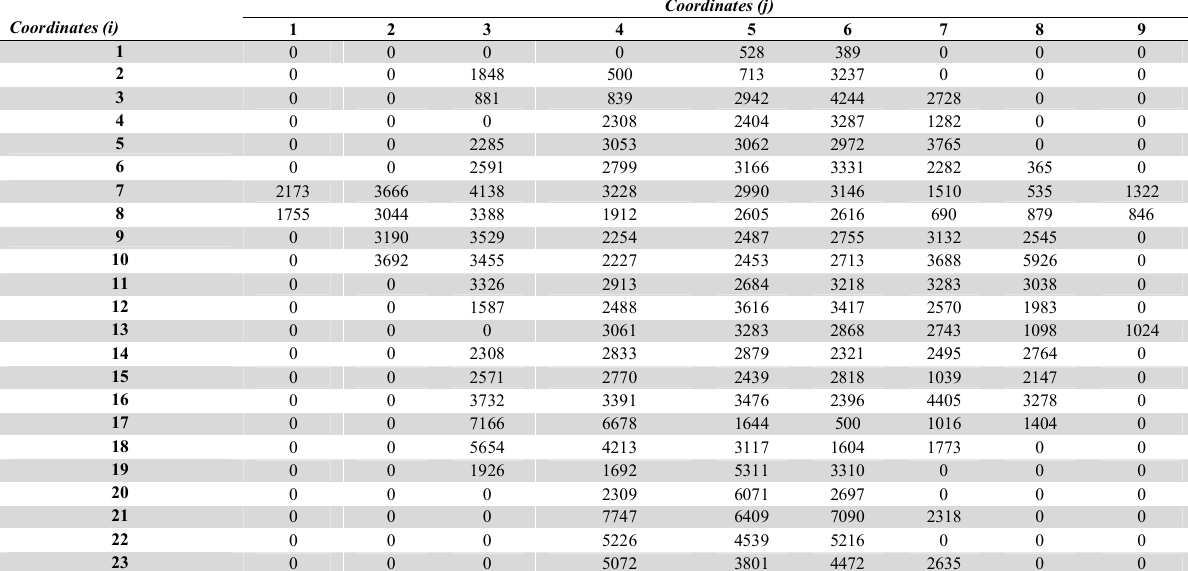
Population of pixels of the region